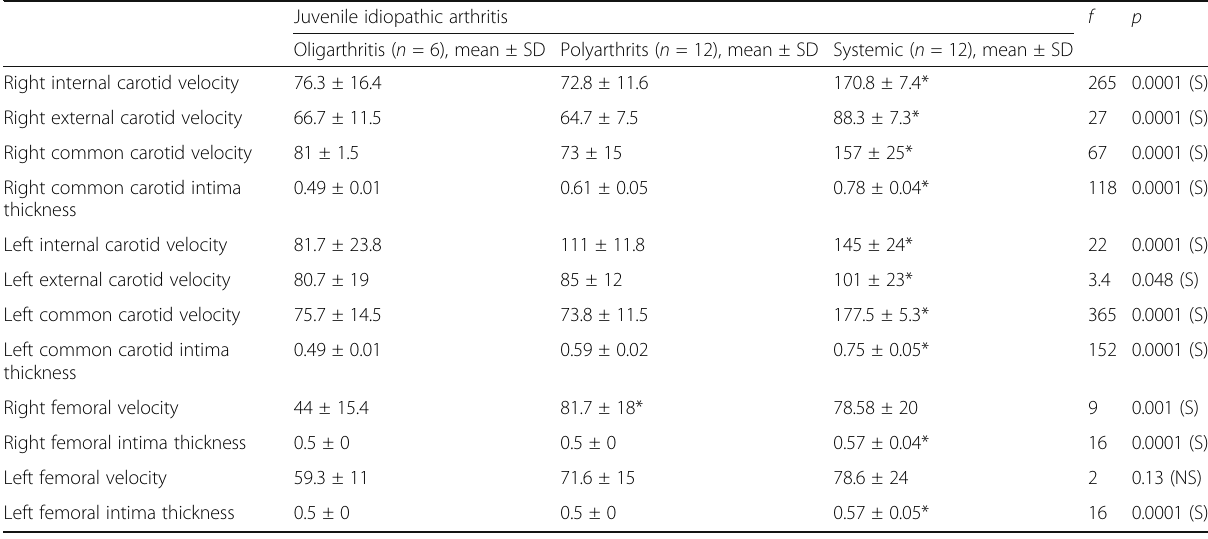
Table 3 Comparison between juvenile idiopathic arthritis patients subtypes as regard parameters of subclinical atherosclerosis by